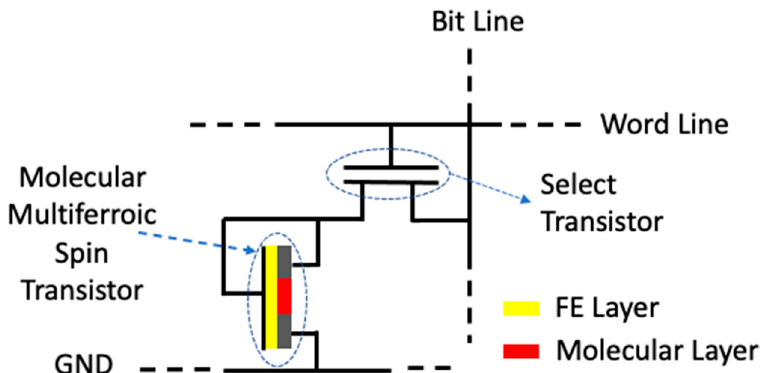
Figure 1. A schematic of a nonvolatile memory element utilizing the multiferroic spin transistor made by spin crossover molecular heteromolecular systems, as described here. The select transistor may be any appropriate transistor switch. It could be a silicon NMOS device, a TFET, or even another molecular multiferroic spin transistor, providing switching does not allow for any memory storage in the select transistor.